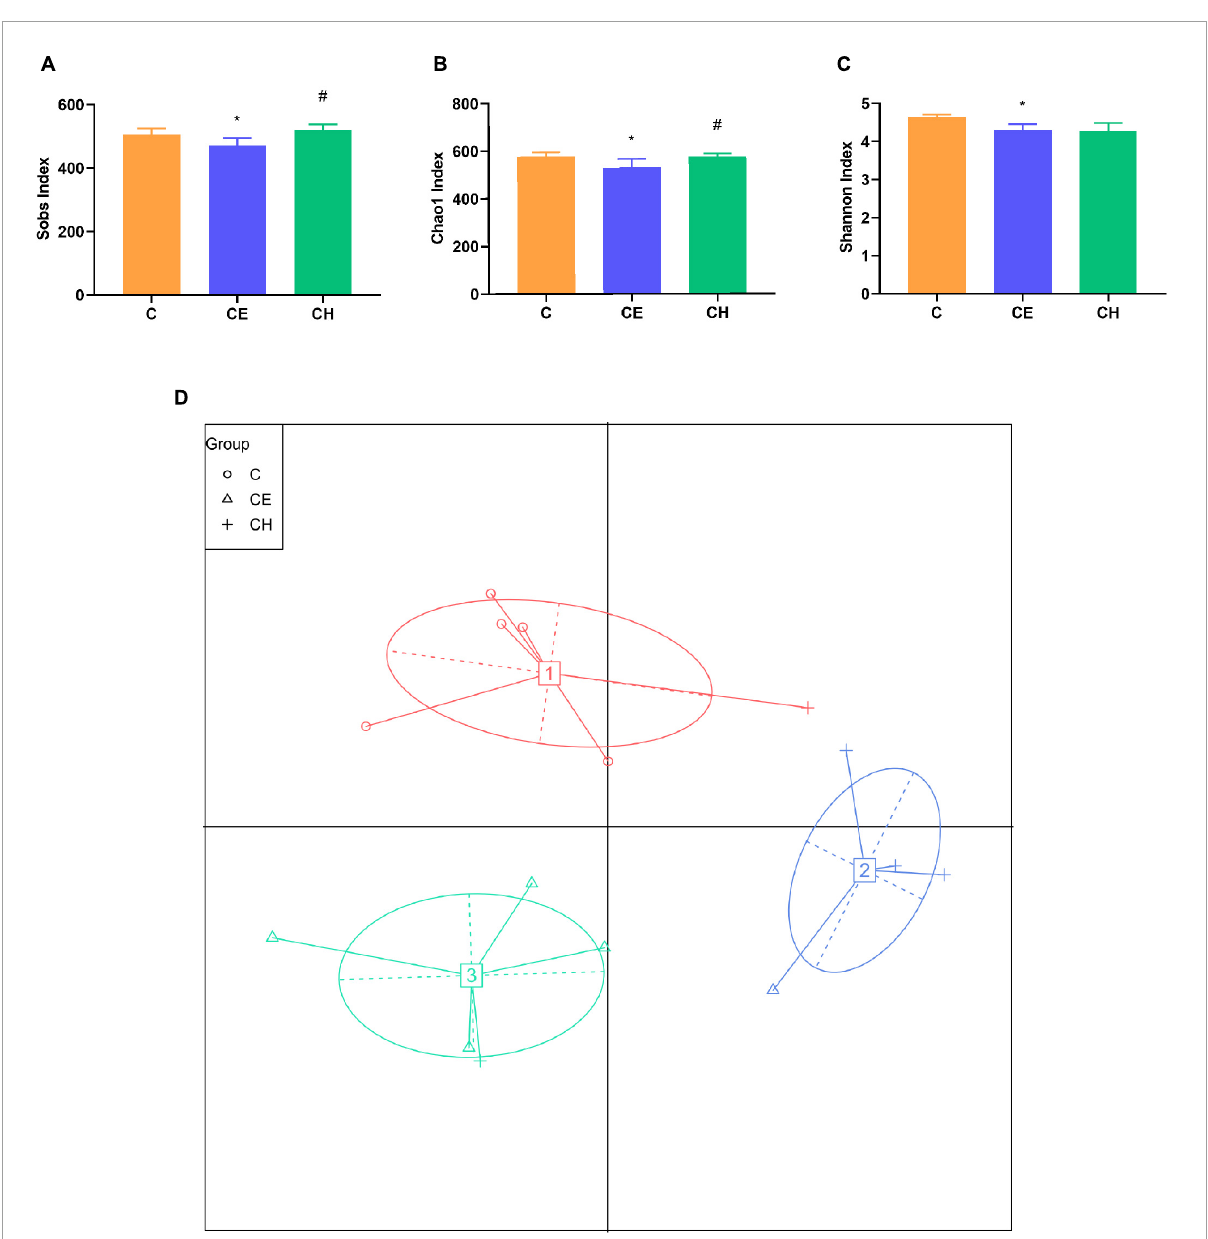
FIGURE7 The diversity of gut microbiota in rats ( n = 5); (A–C) diversity indices of microbial communities in fecal samples, box plots showed differences in the microbiome diversity among C, CE, and CH groups in terms of the sobs index, Chao1 index and Shannon indexes; (D) the effects of intermittent cold exposure on the fecal microbial communities; *Means are significantly different vs. C group (* p < 0.05); # Means are significantly different vs. CE group ( # p < 0.05); C, control group; CE, cold exposure group; CH, Chinese herbs complex